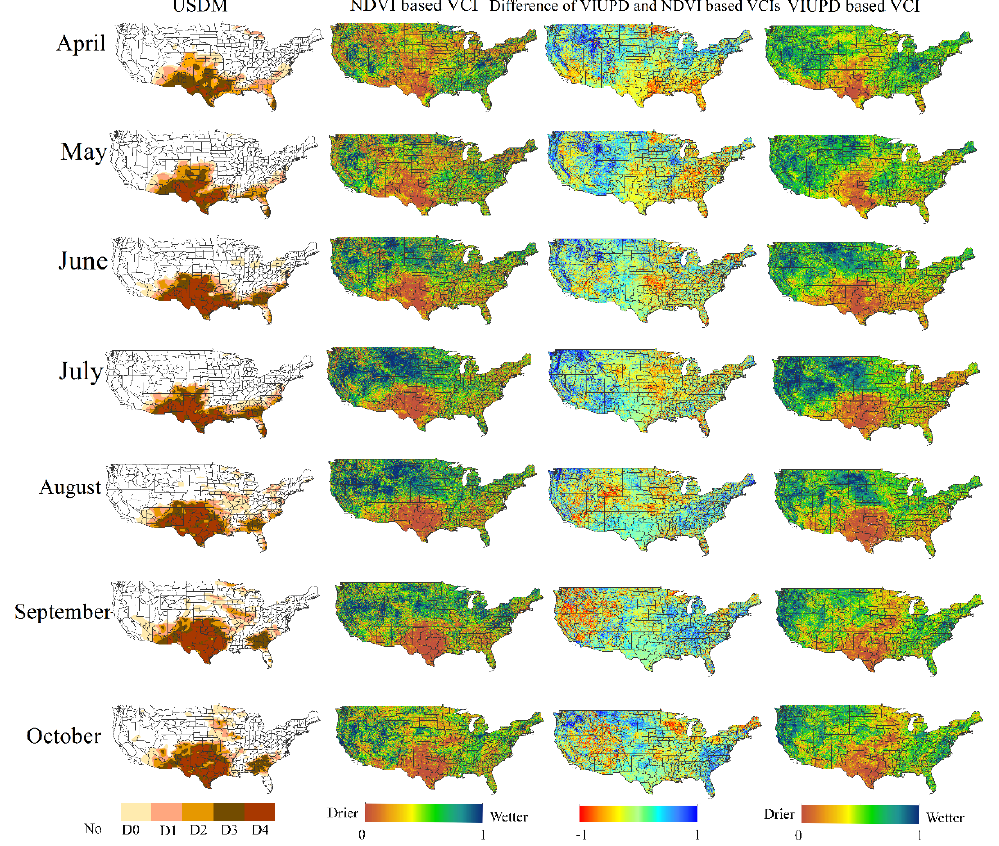
Figure 2. Drought detected by USDM, VIUPD-derived VCI and NDVI-derived VCI for April to October 2011 over the CONUS. The first column is the USDM, the second column is the NDVI-derived VCI, the third column is the VIUPD-based VCI minus the NDVI-derived VCI, and the last column is the VIUPD-derived VCI.